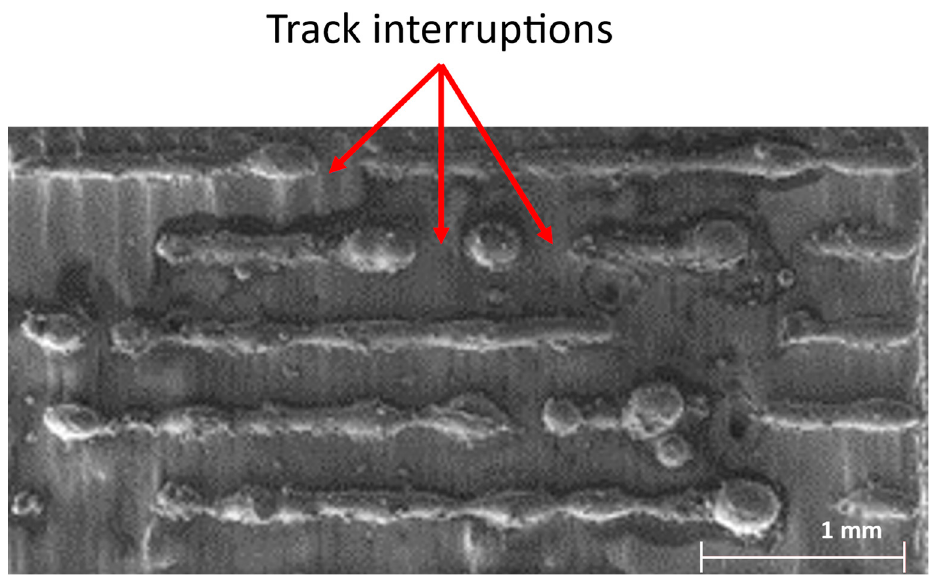
Figure 5. Example of track interruptions.